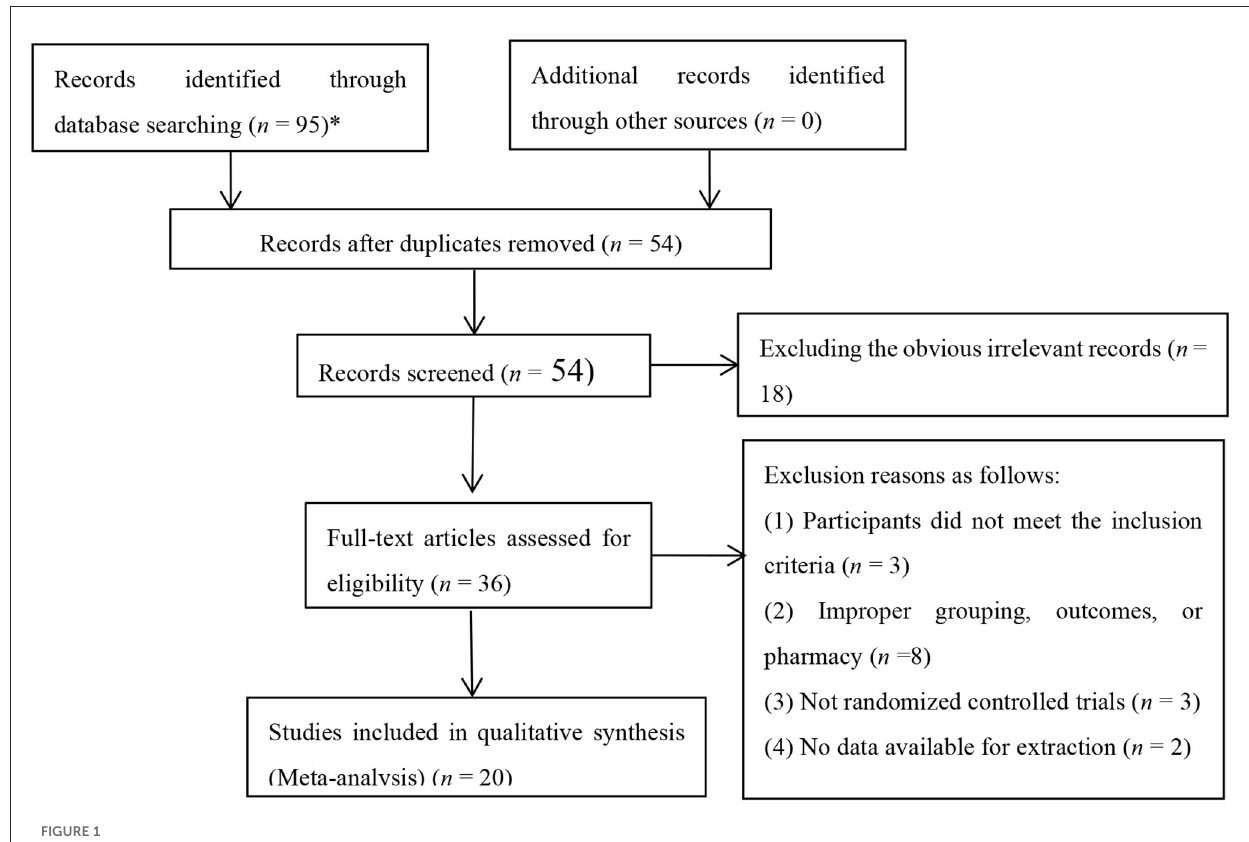
FIGURE1 Flow chart of study selection